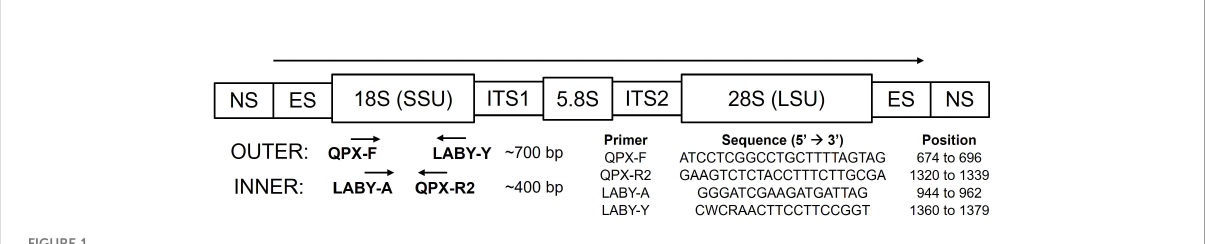
FIGURE 1 Schematic of the ribosomal RNA (rRNA) genes showing primers, respective locations and directions in which they prime, modi fi ed from Qian et al. (2007) with primers from Stokes et al. (2002). Primer positions are based on M. quahogii (QPX) sequence AY052644 in GenBank. NS, nontranscribed region; ES, external transcribed spacer; SSU, small subunit or 18S rRNA gene; ITS1, internal transcribed spacer 1; 5.8S, 5.8S rRNA gene; ITS2, internal transcribed spacer 2; LSU, large subunit or 28S rRNA